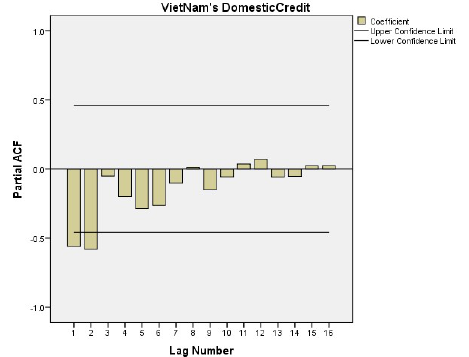
Fig. 7. Vietnam’s Series Autocorrelation Plots (The Box - Jenkins Method, (p=1 & 2))